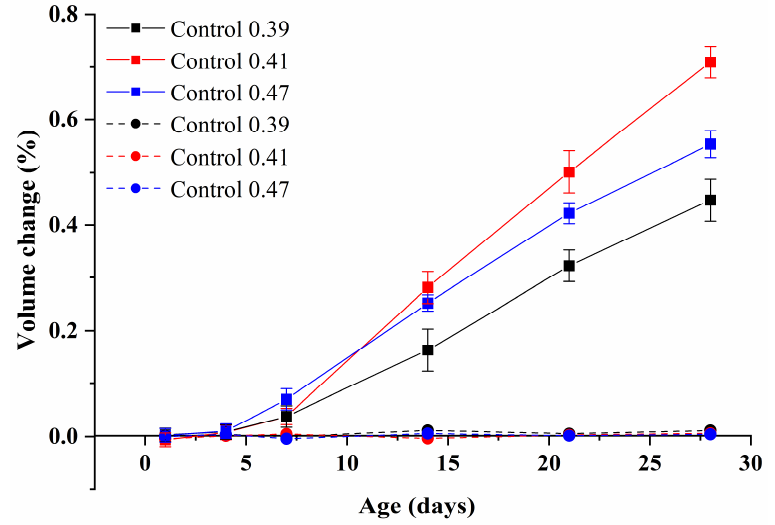
Figure 9. Volume changes of GA mortars with different w/b ratios under alkali curing at 80 °C (solid line) and water curing at 80 °C (dash line).